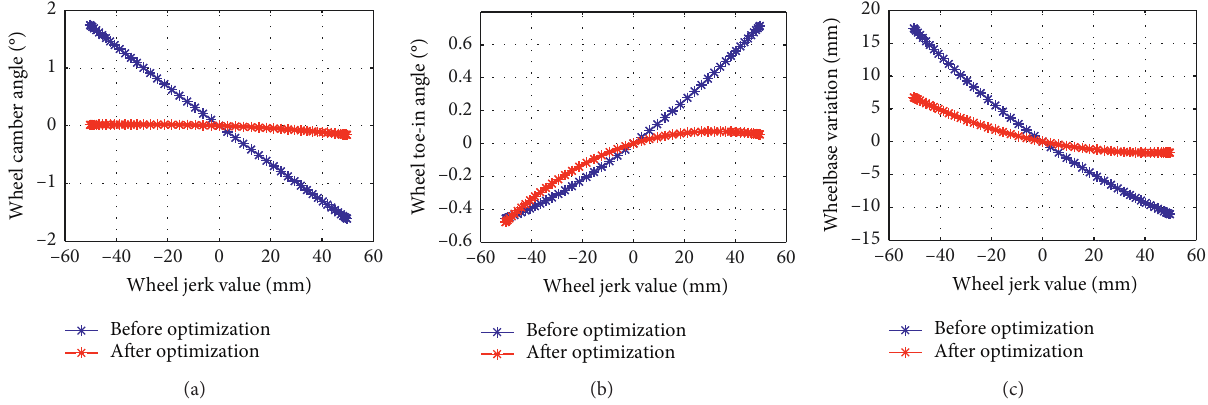
Figure 4: Comparison of (a) wheel camber angle, (b) wheel toe-in angle, and (c) wheelbase variation before and after optimization. Table 4: Comparison of wheel alignment parameters before and after optimization. Wheel alignment parameters